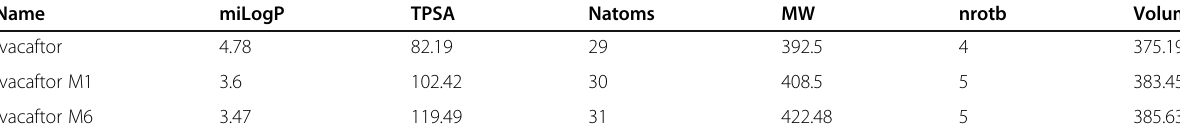
Table 13 Molinspiration calculation of Ivacaftor and its metabolites